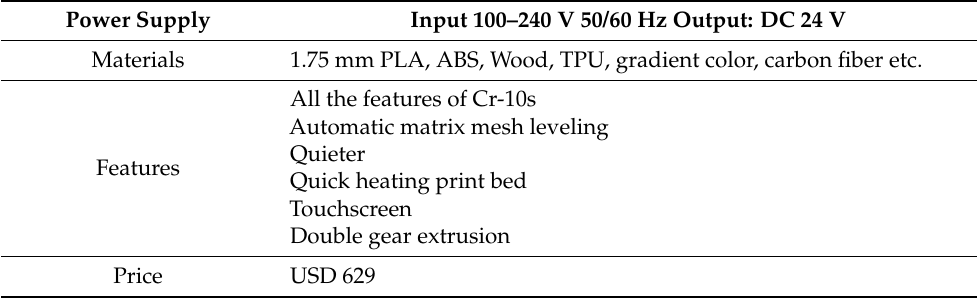
Table 3. Descriptions of Creality 3D Cr-10s Pro Desktop 3D Printer. Power Supply